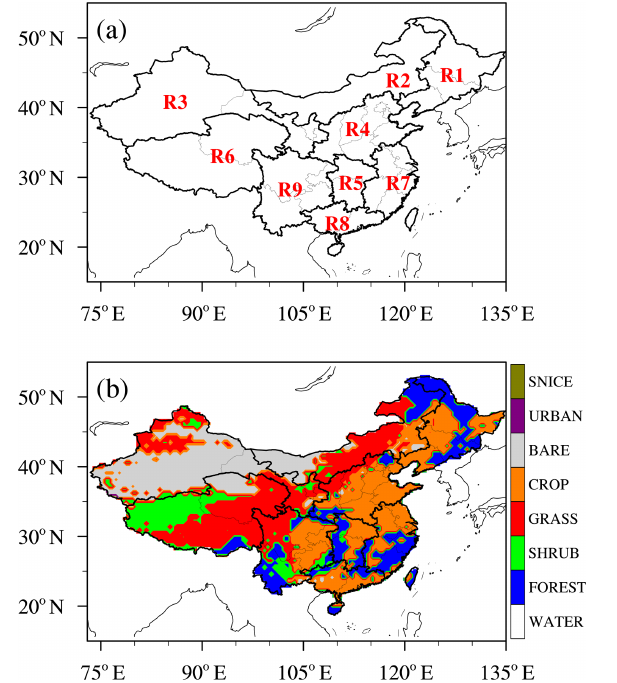
Figure 1. Spatial distributions of (a) nine subregions (R1–R9) in the study region; and (b) present plant functional types (PFTs) used in SG1 simulations. R1: northeastern China (Heilongjiang, Jilin, Liaoning); R2: Inner Mongolia; R3: northwestern China (Gansu, Ningxia, Xinjiang); R4: northern China (Beijing, Hebei, Henan, Shandong, Shanxi, Shaanxi, Tianjin); R5: central China (Hubei, Hu- nan); R6: Tibetan Plateau (Qinghai, Tibet); R7: southeastern China (Anhui, Fujian, Jiangsu, Jiangxi, Shanghai, Zhejiang) and Taiwan; R8: southern China (Guangdong, Guangxi, Hainan, Hong Kong, Macao); and R9: southwestern China (Guizhou, Sichuan, Yunnan, Chongqing). SNICE is snow and ice; BARE is bare